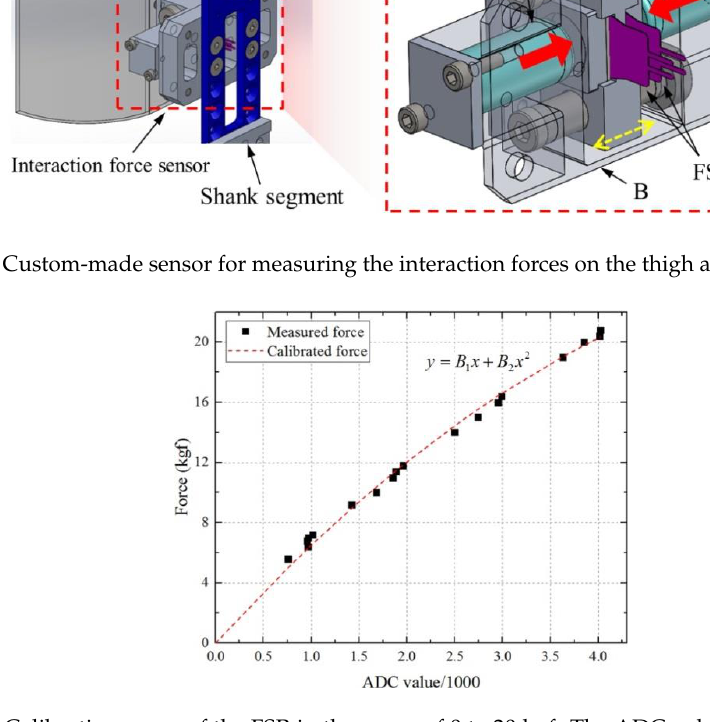
Figure 8. Custom-made sensor for measuring the interaction forces on the thigh and shank segments.